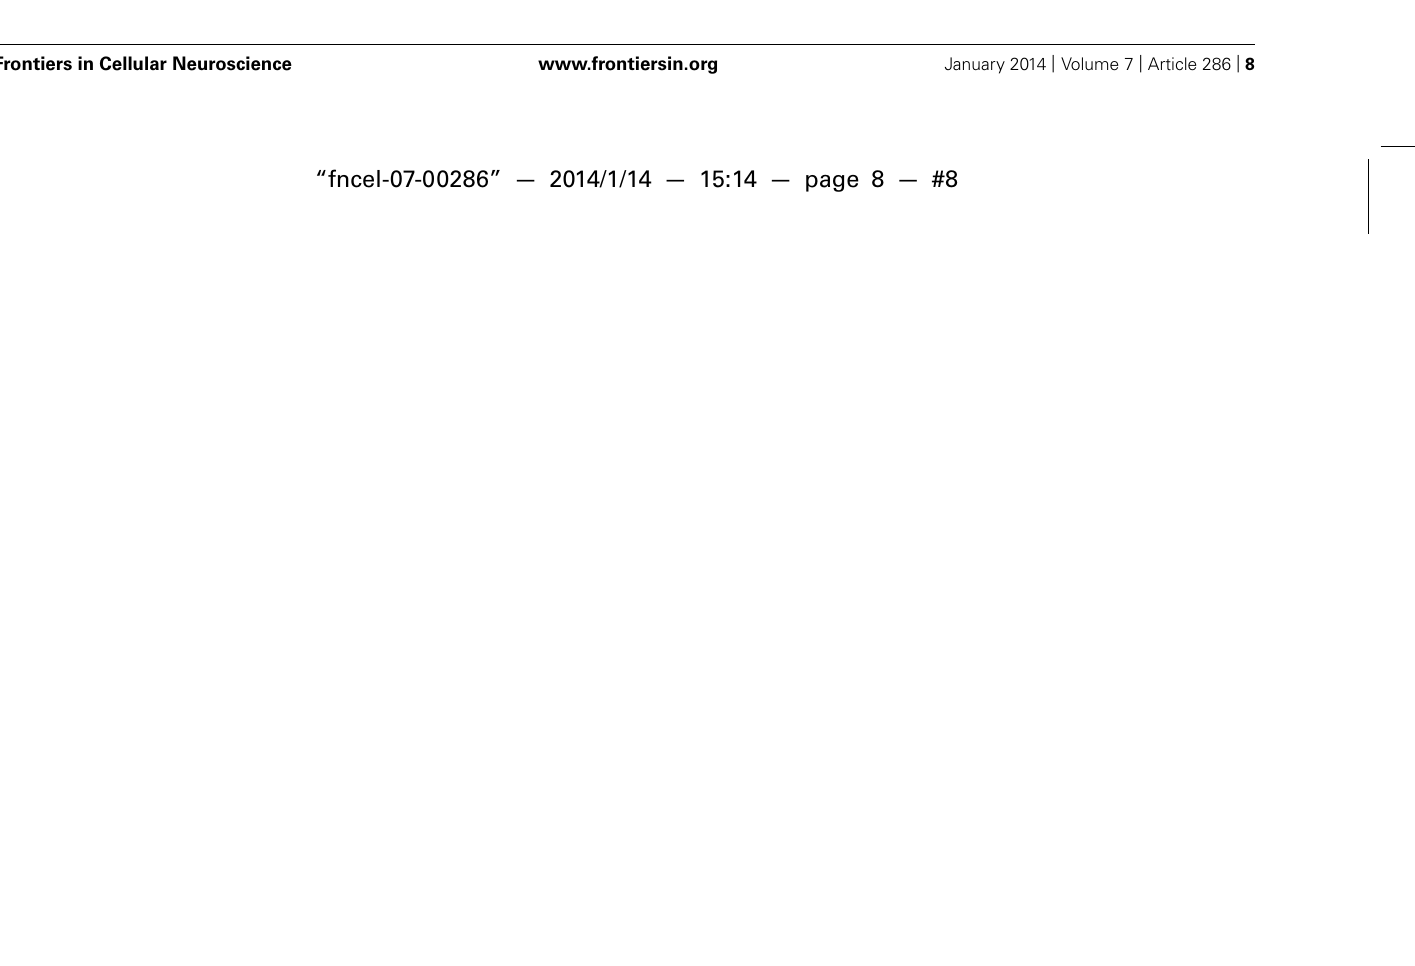
Each value represents the mean ± SEM. (B) Typical hind paw footprints for the control and L7-VGAT mice at P40W. (C) Hind paw stride lengths and widths at postnatal weeks 16 and 40 for control and L7-VGAT mice. Each value represents the mean ± SEM.The numbers of animals were n = 5 in the control group (open bar) and n = 4 in the L7-VGAT (filled bar) group.The asterisk and N.S. represent p < 0.05 and p > 0.05, respectively (Student’s t